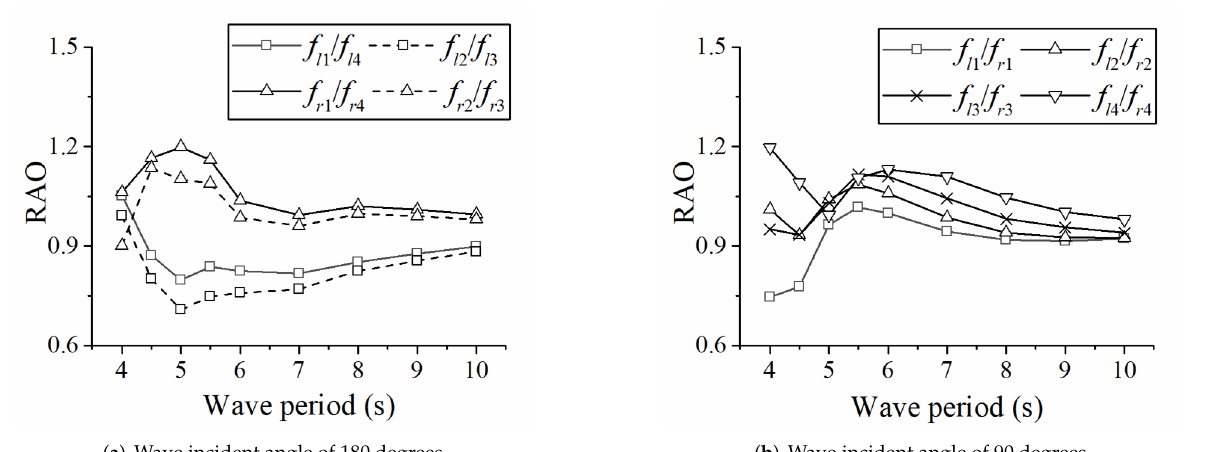
Figure 10. Heave motion response of floaters in different wave periods (four floaters on one